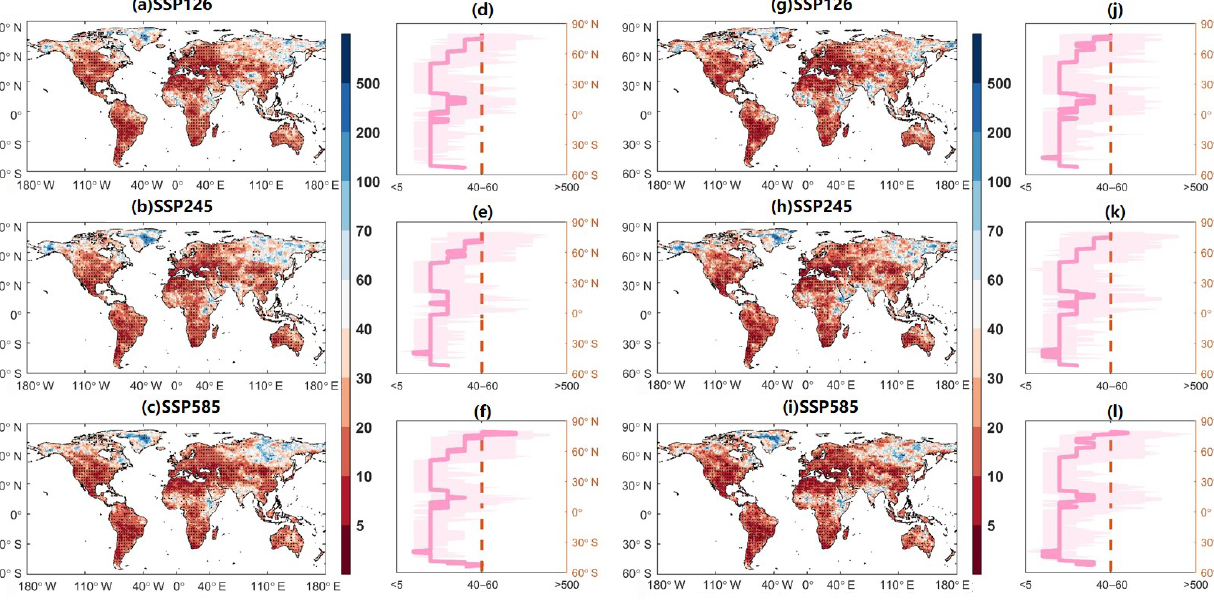
Figure 14. Projected changes in joint 50-year return periods of droughts when using − 0 . 5 as the threshold and − 0 . 8 as the threshold under the 1.5 ◦ C warming